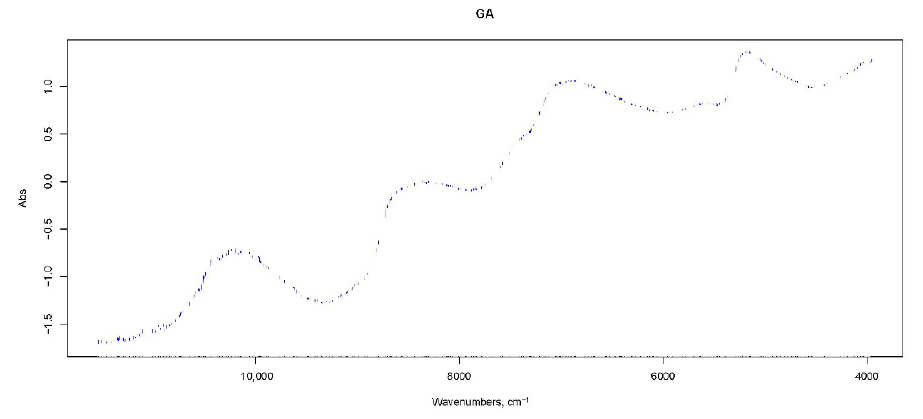
Figure 4. GA-selected regions of NIR spectrum.